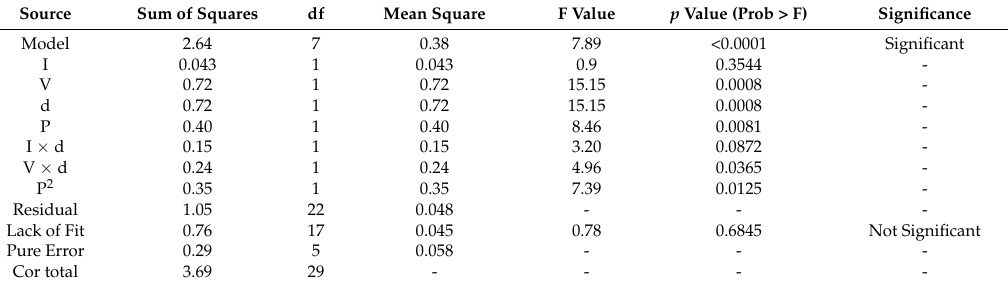
Table 6. Results of ANOVA for model of weld